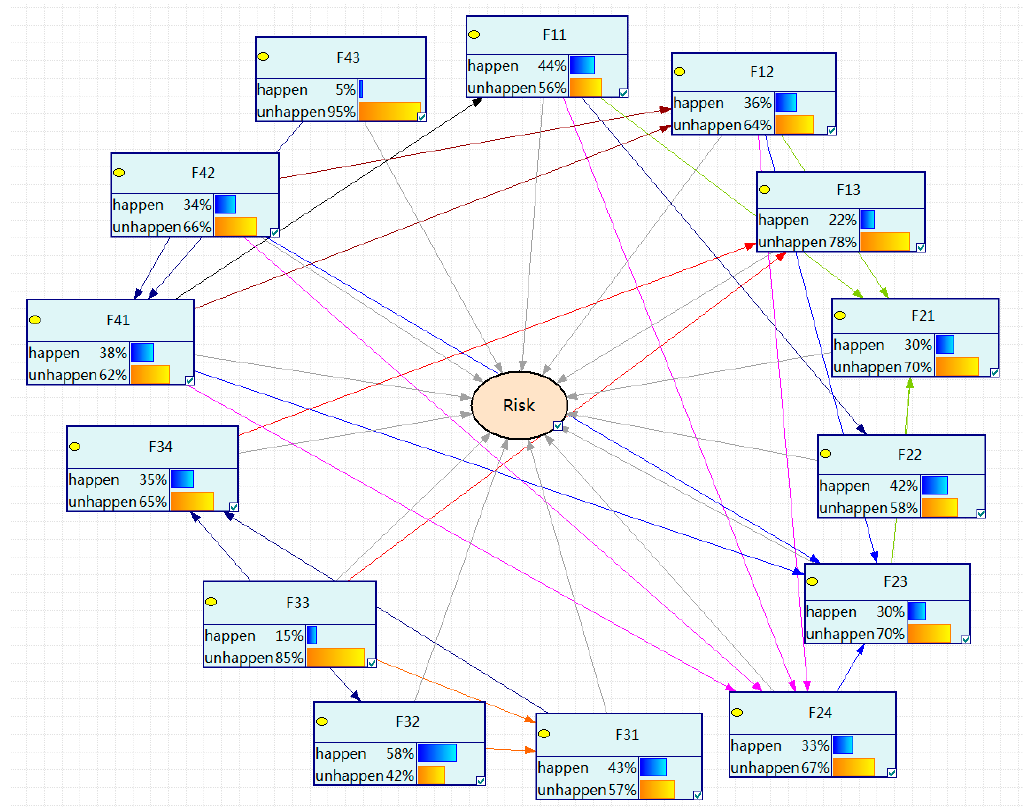
Figure 7. The probabilistic inference diagram based on the BN.